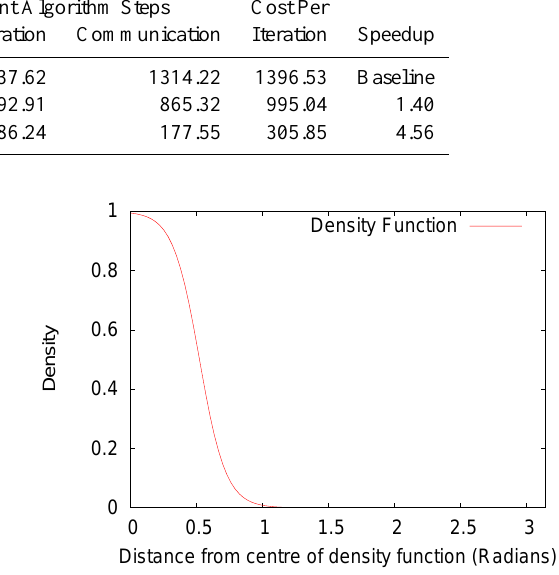
Fig. 4. Density function that creates a grid with resolutions that dif- fer by a factor of 8 between the coarse and the fine regions. The Fig. 6. Density function that creates a grid with resolutions that differ by a factor of 8 between the coarse and maximum value of the density function is 1 whereas the minimum value is ( 1 / 8 ) 4